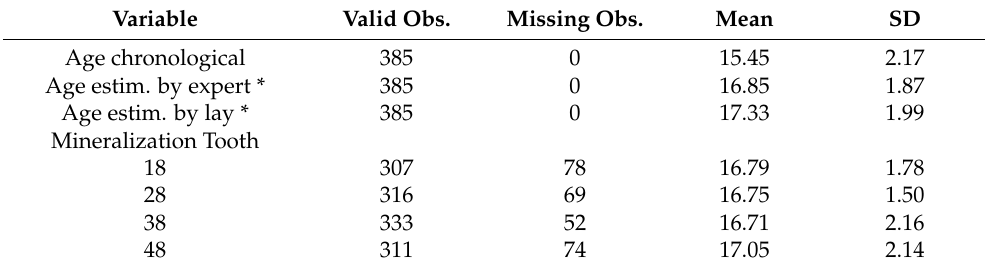
Table 1. Sample description.